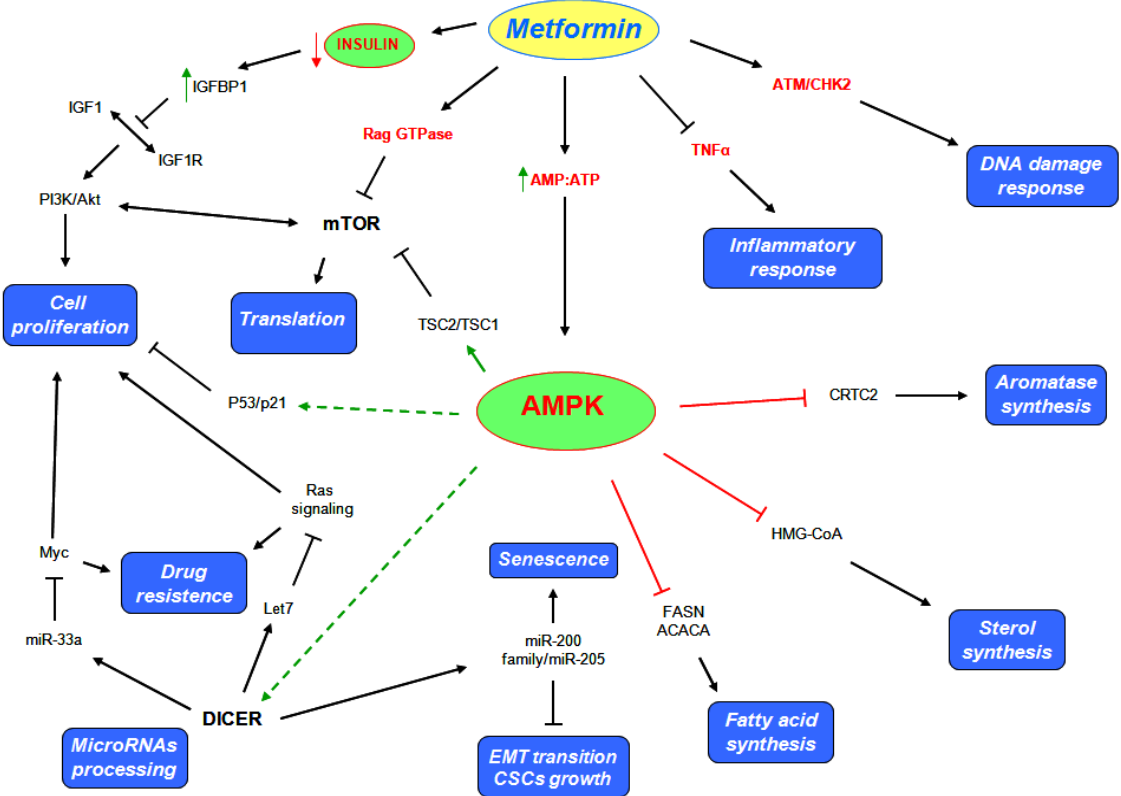
Figure 2. Metformin triggers multiple pathways to exert its anticancer